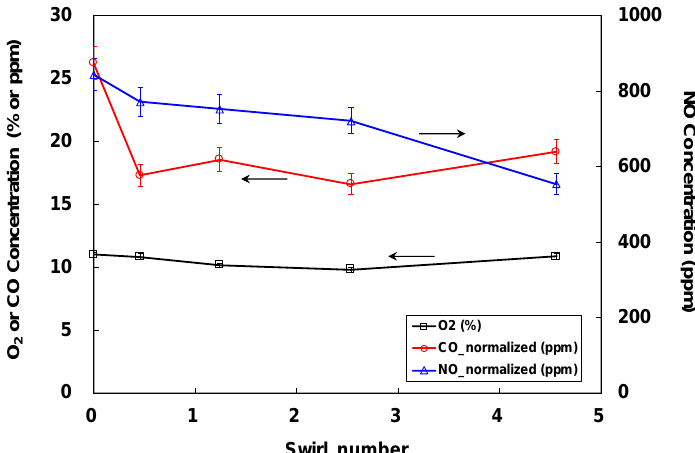
Figure 9. O 2 concentration (%), normalized CO and NO concentrations (ppm) for various swirl numbers at p = 150 kPa and φ = 0.8.